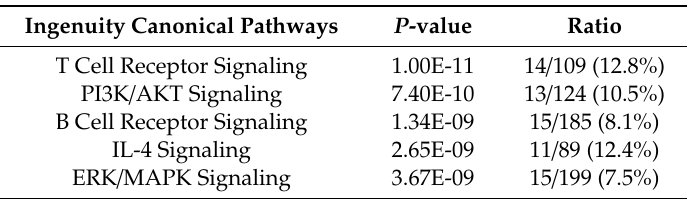
Table 9. Top canonical pathways from